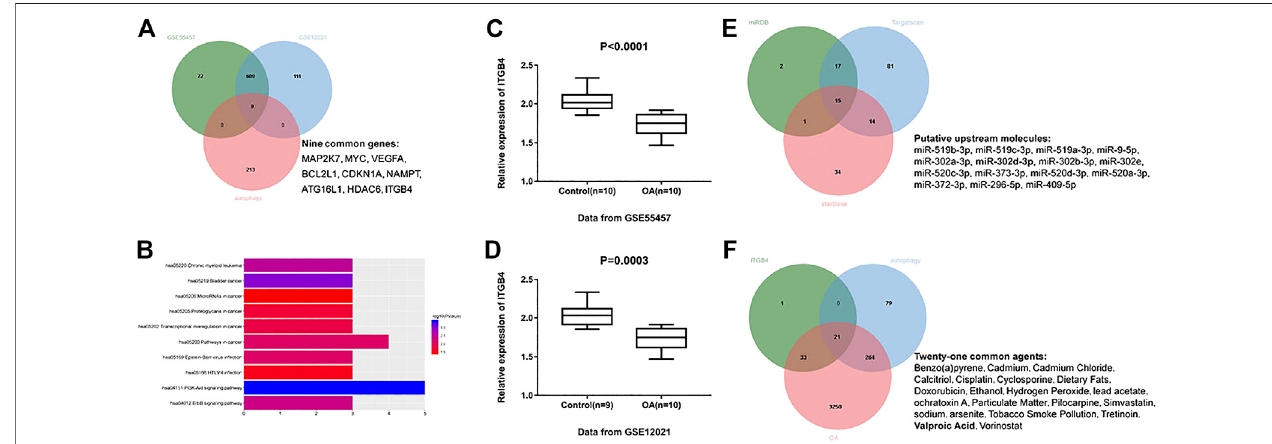
FIGURE 1 | Identi fi cation of potential biomarkers and agents in OA. (A) Intersection of differentially expressed genes identi fi ed based on GSE55457, GSE12021, and autophagy-related genes. Green indicates differentially expressed genes based on GSE55457; blue indicates differentially expressed genes based on GSE12021; red indicates autophagy-related genes downloaded from HADb websites. (B) The top ten meaningful signaling pathways were identi fi ed by analyzing the above nine common genes in the DAVID website for KEGG pathway enrichment analysis. (C) Relative expression of ITGB4 was decreased in OA tissues ( n (cid:2) 10) compared with normal controls ( n (cid:2) 10) on the basis of GSE55457. p < 0.0001. (D) GSE12021 dataset showed a decreased ITGB4 level in OA tissue samples ( n (cid:2) 10) compared with controls ( n (cid:2) 9). p (cid:2) 0.0003. (E) miR-302d-3p was identi fi ed as a putative upstream factor of ITGB4, according to the bioinformatics prediction. Green represents potential miRNAs using miRDB; blue represents potential miRNAs using TargetScan; red represents potential miRNAs using starBase. (F) VPA was screened out as a potential drug related to OA progression, autophagy, and ITGB4 expression. Green indicates potential drugs related to ITGB4 expression; blue indicates autophagy- related drugs; red indicates OA-related drugs. Data were expressed as the mean ± SD (Student ’ s t